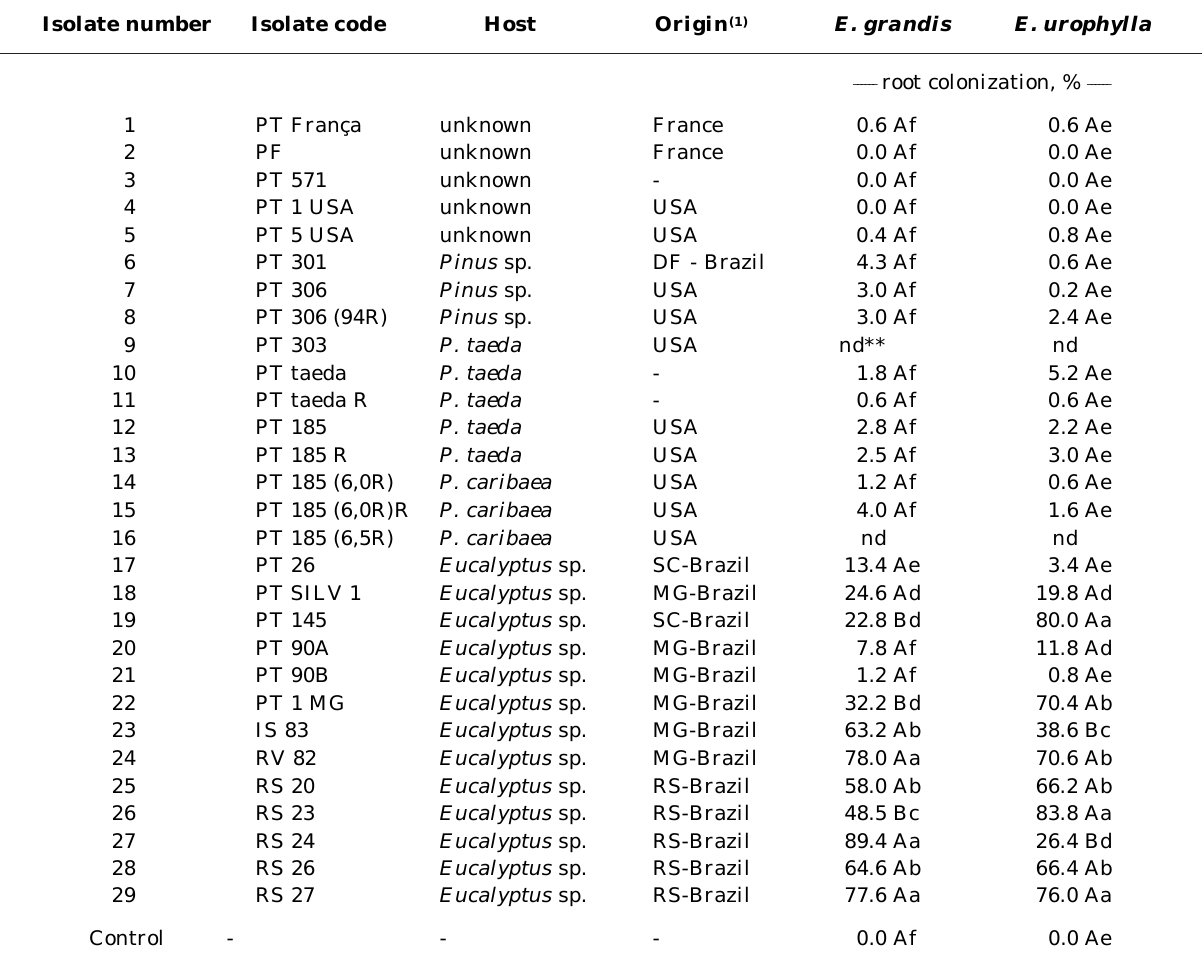
Table 1. Number, code, host, geographical origin and root colonization of Pisolithus sp. isolates inoculated onto E. grandis and E.